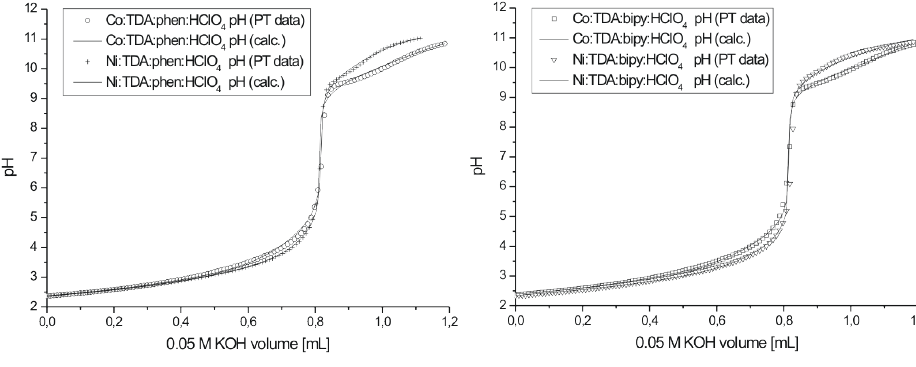
Figure 1 : Potentiometric titration curves of the systems under study at 298.15 K.